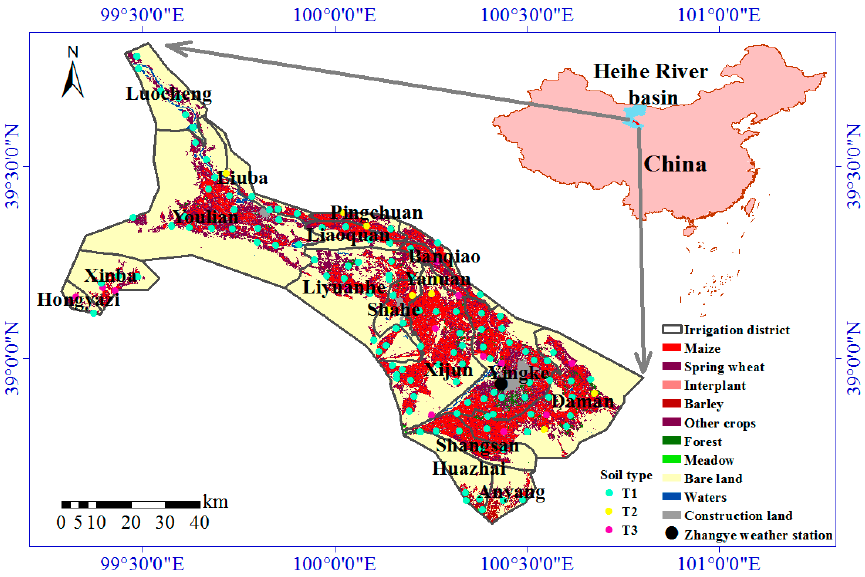
Figure 1. Geographic locations, land use and crop patterns in the study area. Table 1. Results of soil survey on the layered soil samples.